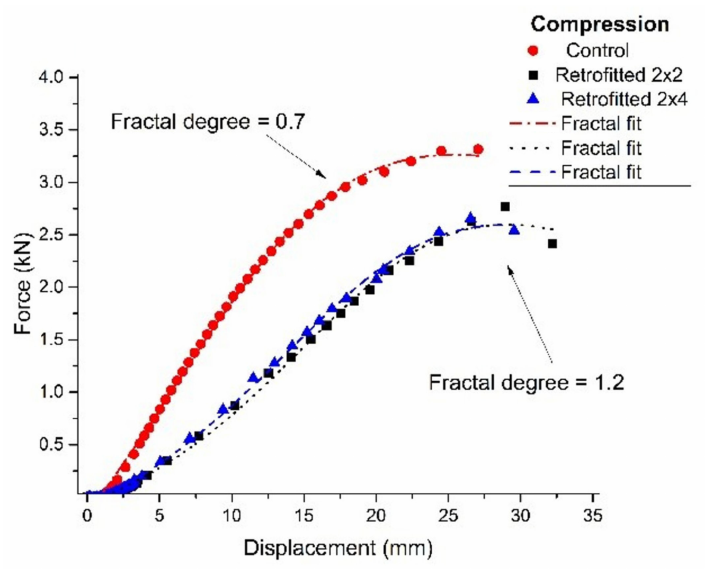
Figure 10. Behavior of samples rehabilitated with “liquid wood”, subjected to compression.